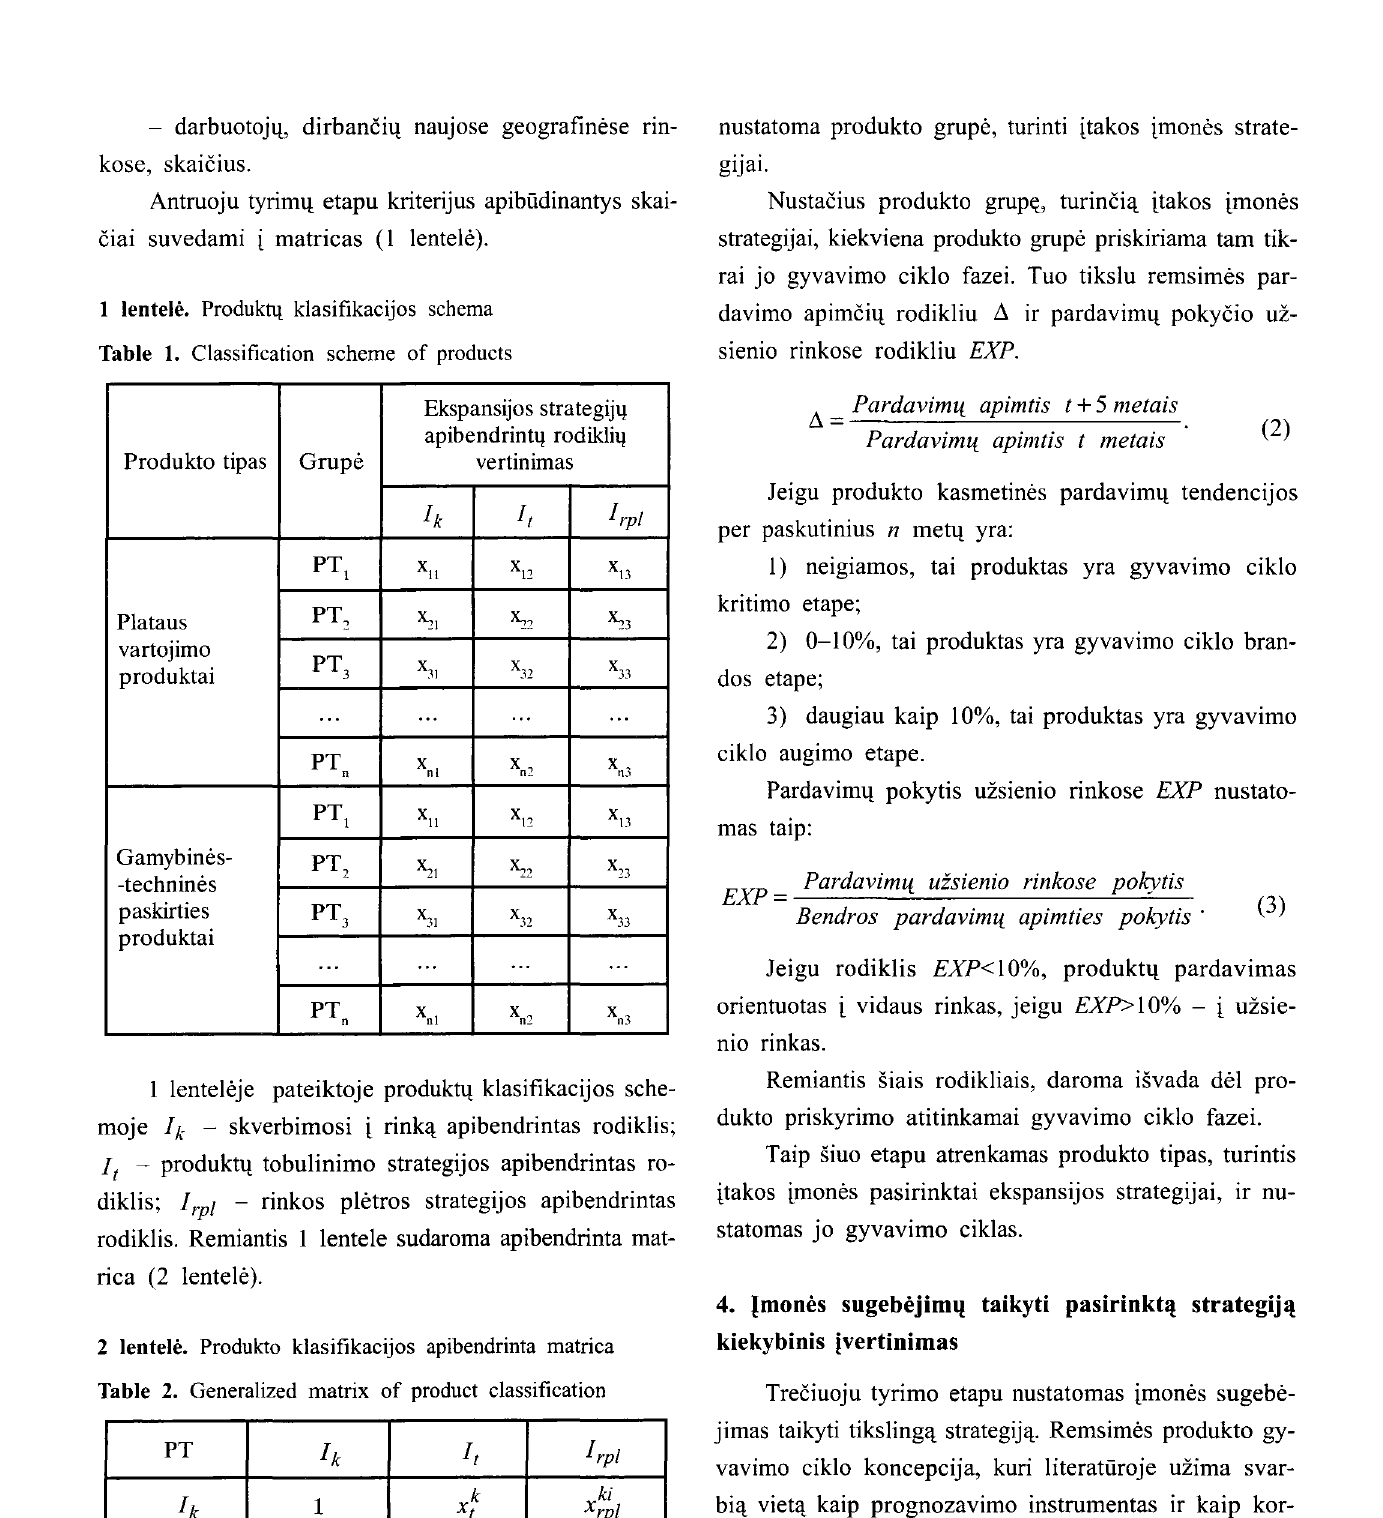
Table 2. Generalized matrix of product